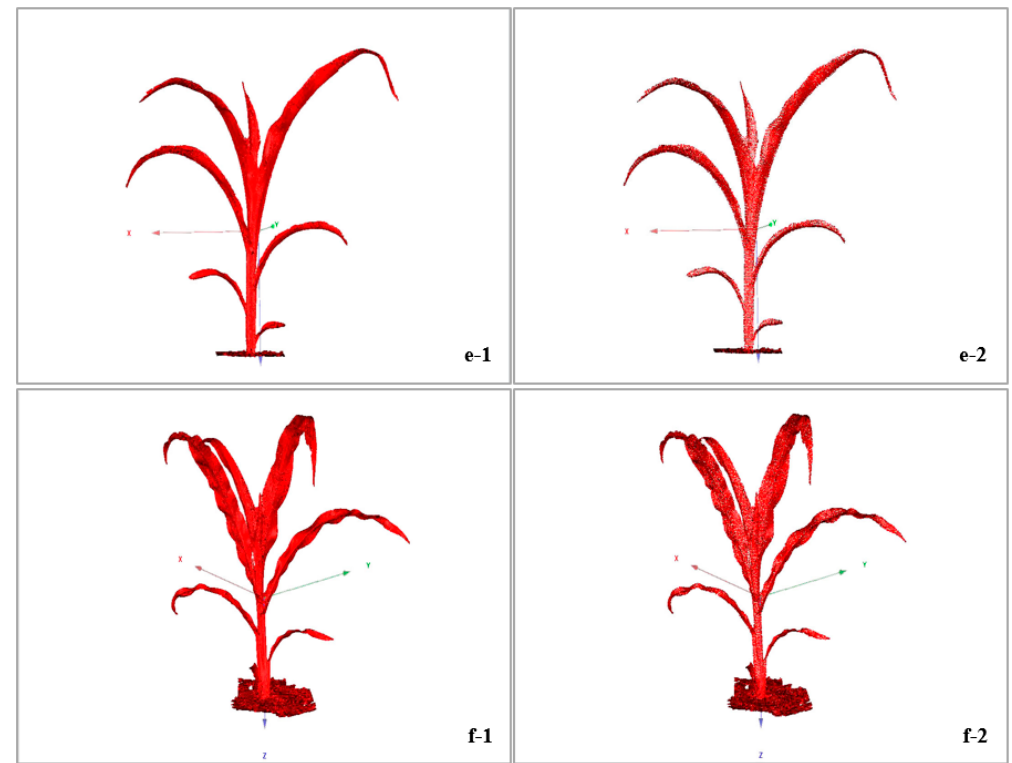
Figure 10. Overall effect after simplification in maize from the trefoil stage to the jointing stage. ( a- 1 , a-2 ) A maize plant at the trefoil stage (the number of 3D cloud points was simplified from 10,256